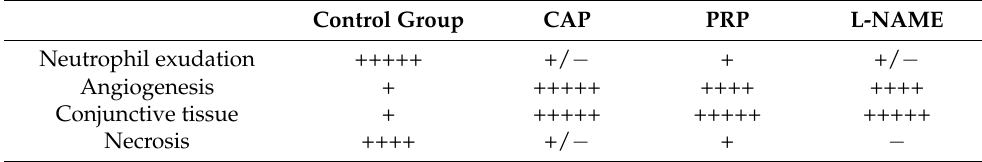
Table 2. Scoring of the histological findings in control and treated groups at flaps’ level. Control Group CAP